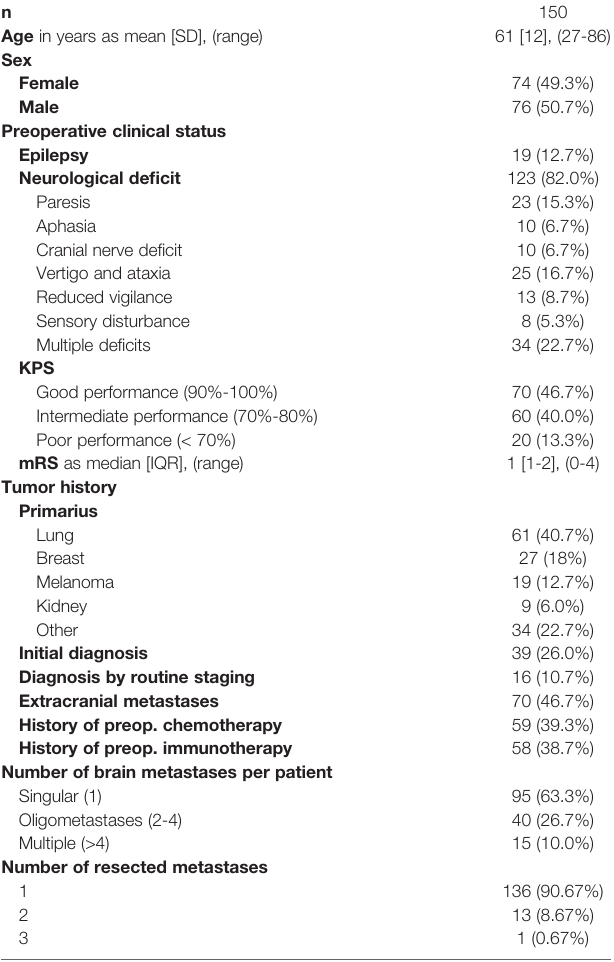
Table 1 presents the patients characteristics. KPS, Karnfosky Performance Status Scale; mRS, Modi fi ed Rankin